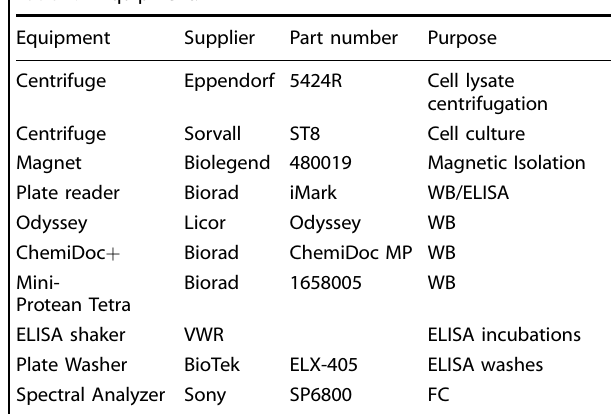
Table 1. Neuron culture